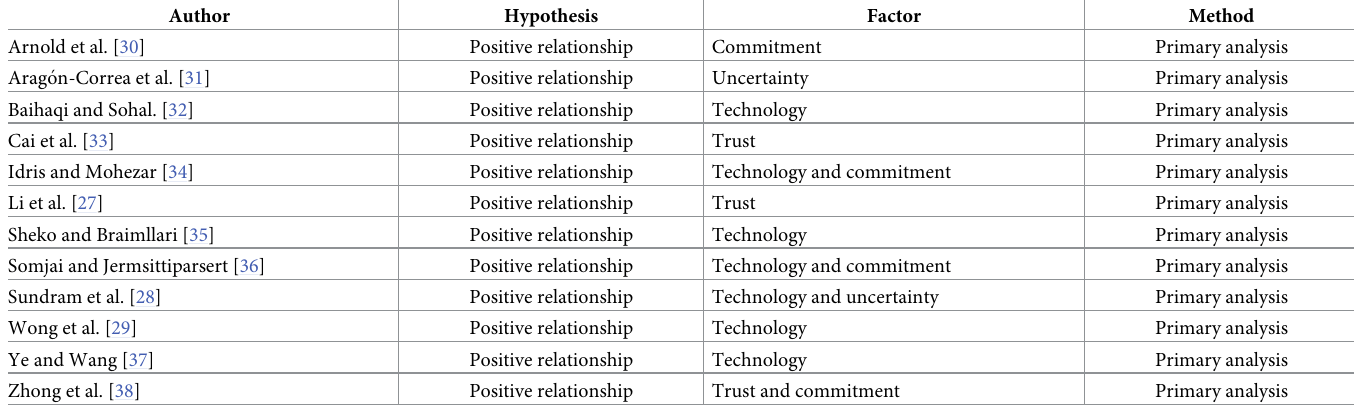
Table 1. The methods and hypotheses of the relationships between factors and information sharing in previous